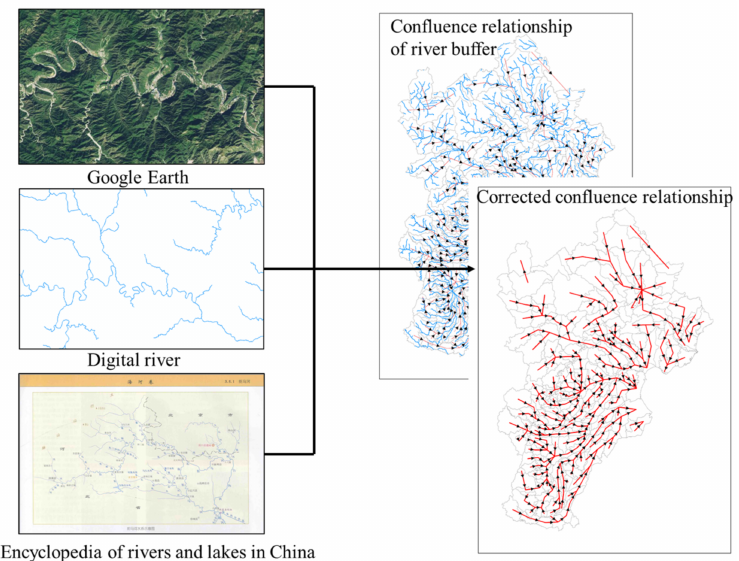
Figure 12. The corrected confluence relationship of Jing-Jin-Ji region.